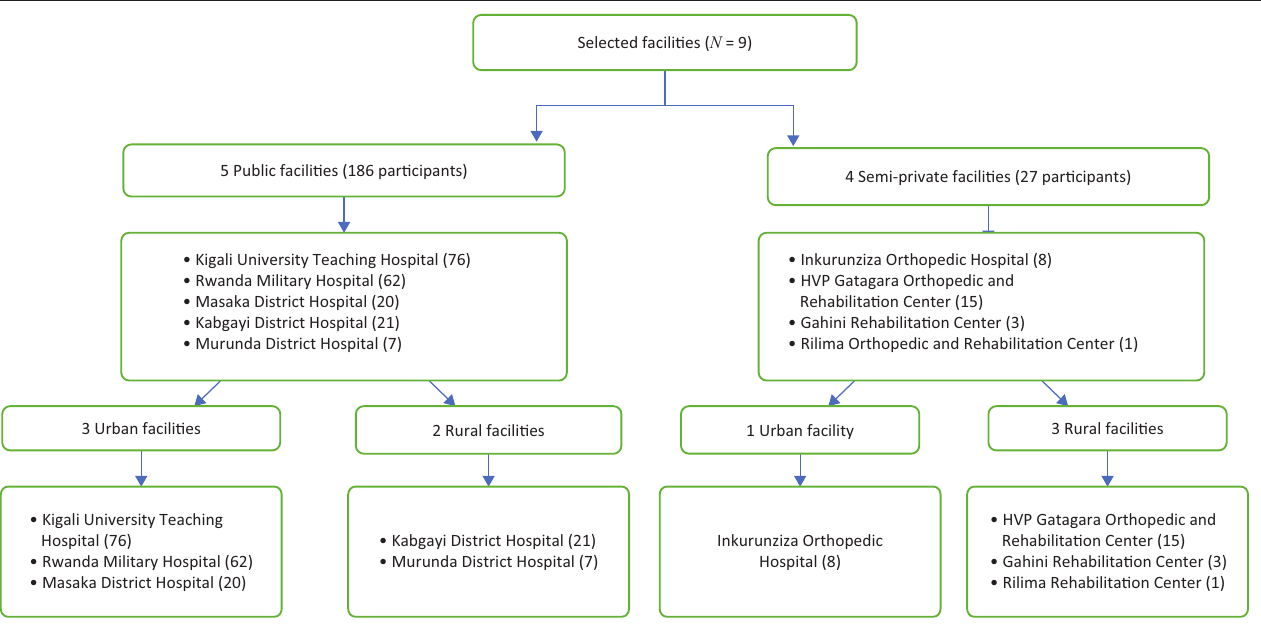
FIGURE 1: The number of recruited participants at each facility, divided into public versus semi-private facilities and urban versus rural